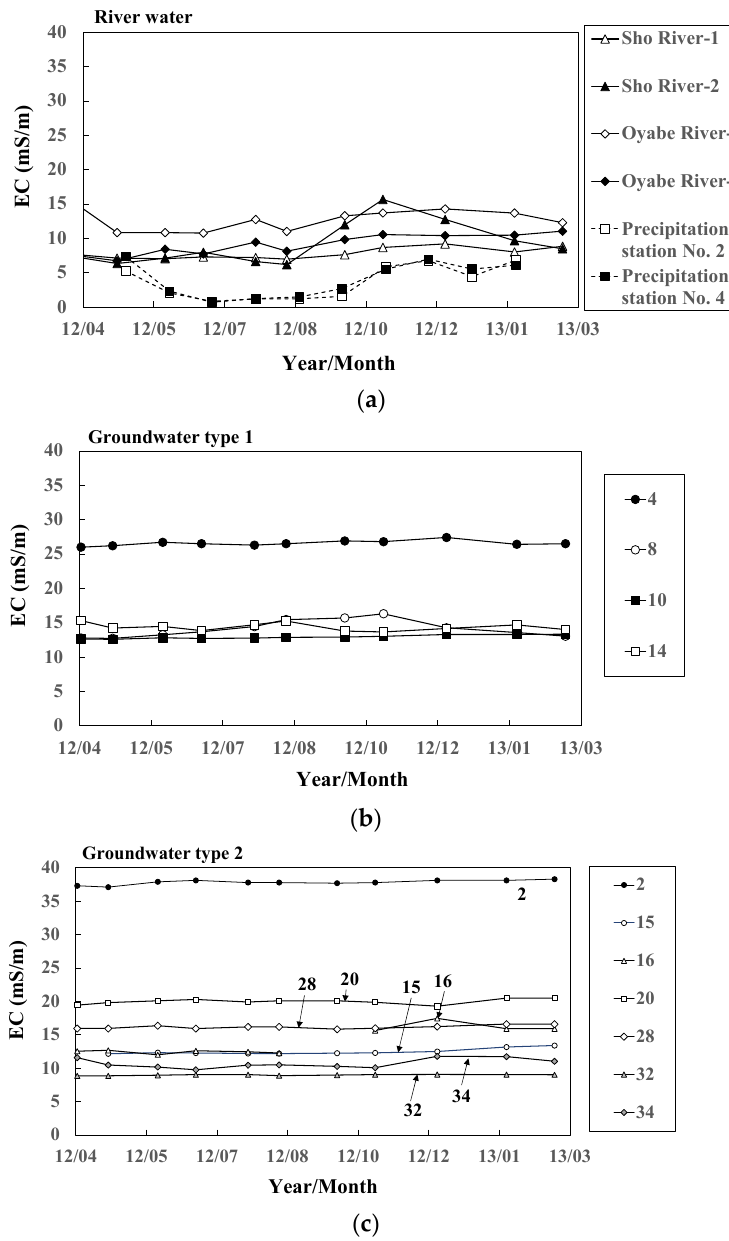
Figure 6. Seasonal variation of electric conductivity in ( a ) river water and groundwater (( b ) Types 1 and ( c ) 2) at 11 representative sites.